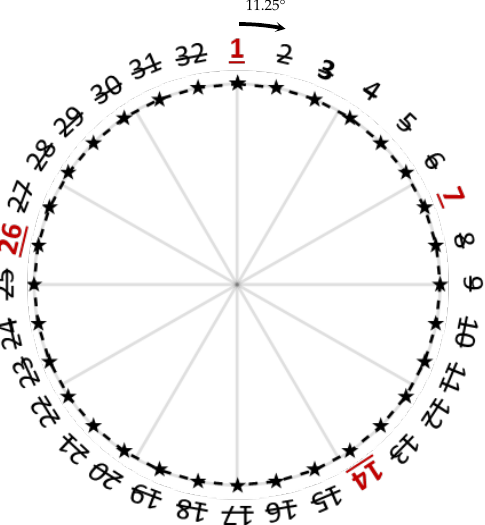
Figure 8. The used reception points of each ring in the FEM.